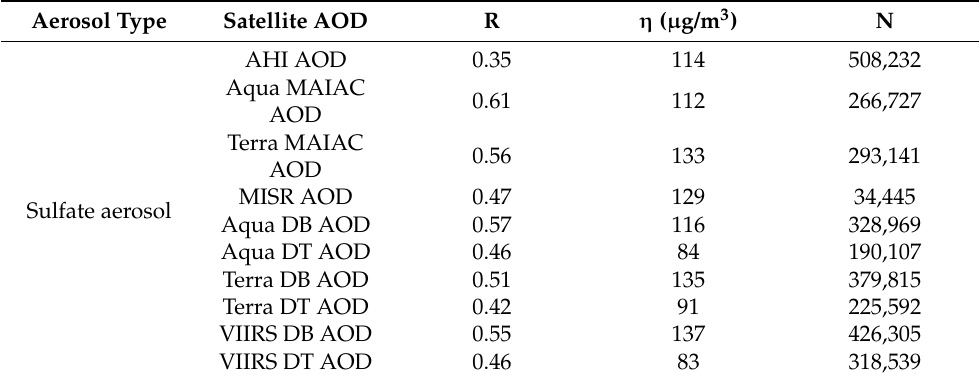
Figure 6. Seasonal fluctuations of the correlation coefficients (R), q-statistics ( a ), and spatial-temporal collocations ( b ) of AODs-PM 2.5 over China and its 14 typical urban agglomerations. The black down triangle is the q-statistics of geo-detectors for each season; the different colored bars represent the relationship between multi-AODs and PM 2.5 . Table 2. The association between satellite AODs and PM 2.5 under different aerosol dominant types over China. R (correlation coefficient), η (PM 2.5 /AOD), and N (spatial-temporal